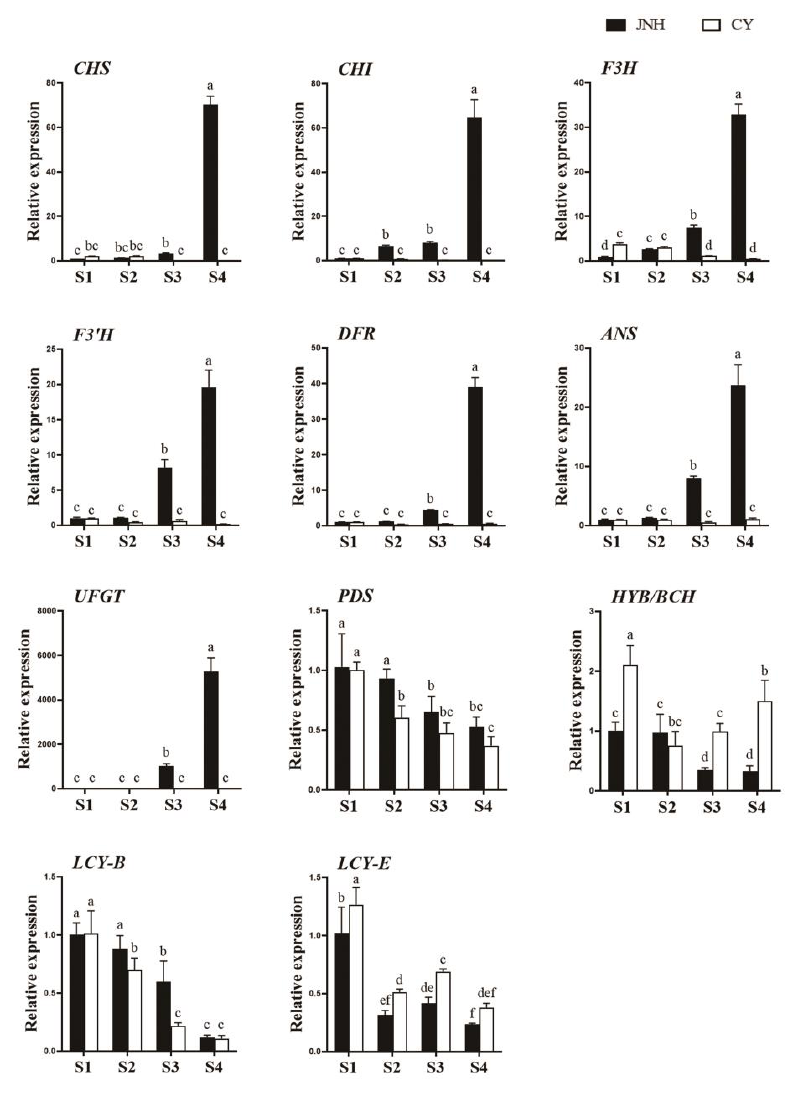
Figure 5. Expression analysis of eleven genes related to anthocyanin and carotenoid biosynthesis in sweet cherry using qRT-PCR. The standard error of the mean for three biological replicates (nested with three technical replicates) is represented by the error bars ( p < 0.05). Significant differences were calculated using one-way analysis of variance (ANOVA) followed by Duncan’s multiple-range test at the 5% level (p < 0.05), and are shown in Tables 2 and 3 with lowercase letters (a, b, c, d, e, f) between